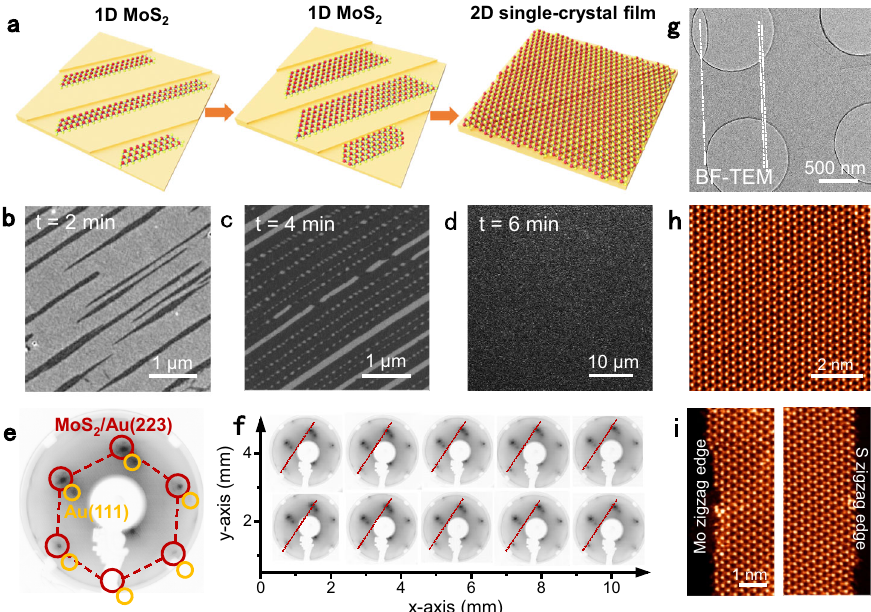
Fig. 4 Monolayer single-crystal MoS 2 fi lms achieved by the growth and merging of monolayer MoS 2 ribbons. a Schematic illustration regarding the growth of monolayer MoS 2 single-crystal fi lm through the merging of MoS 2 ribbons. Red and yellow spheres represent Mo and S atoms, respectively. b – d SEM images showing the growth process from narrow MoS 2 ribbons ( b ), wide ribbons ( c ), to continuous 2D fi lm ( d ) by extending the growth time (t) from ∼ 2, ∼ 4, to ∼ 6 min, respectively. e Representative LEED pattern of monolayer MoS 2 single-crystal on the Au(223) facet. The spots indicated by red circles show the moiré satellite peaks for MoS 2 /Au(223). The spots indicated by yellow circles arise from the Au(111) facet. f More LEED patterns collected over an area of 10 mm × 4 mm. The red lines in the same direction indicate the same orientation of these patterns. g Low-magni fi cation bright- fi eld TEM image of a nearly full-coverage MoS 2 fi lm transferred on the TEM grid. h Atomically resolved STEM image of the monolayer MoS 2 fi lm, con fi rming its defect-free feature. i STEM images captured from the left and right edges of a monolayer MoS 2 ribbon presenting Mo-zz and S-zz edges,